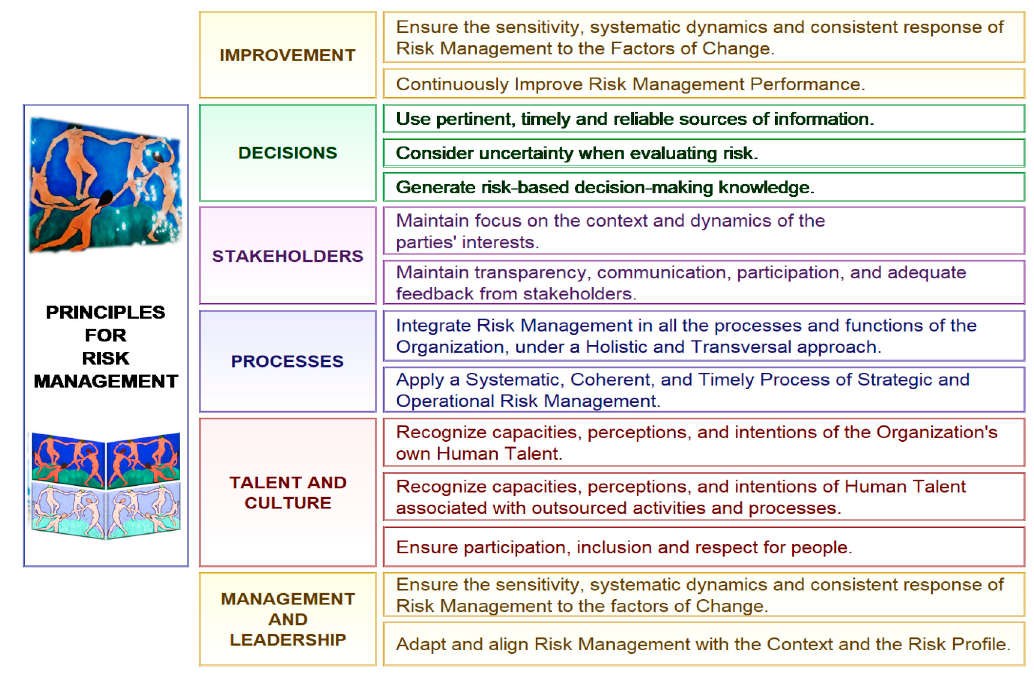
Figure 2. Principles of risk management based on ISO 31001 and ISO 22301 [13,14,50,51].